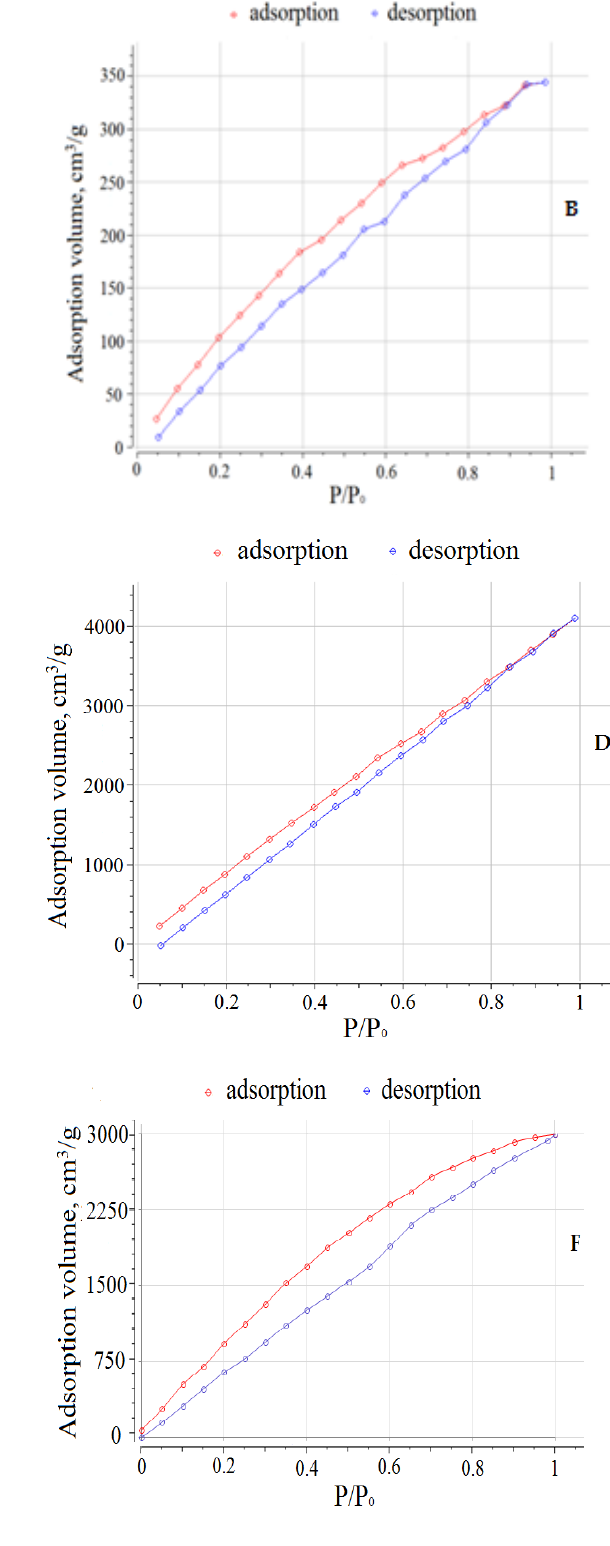
Figure 7. Adsorption and desorption isotherms of the compounds 1 ( A ), 6 ( B ), 7 ( C ), 2 ( D ), 3 ( E ), and 4 ( F ).